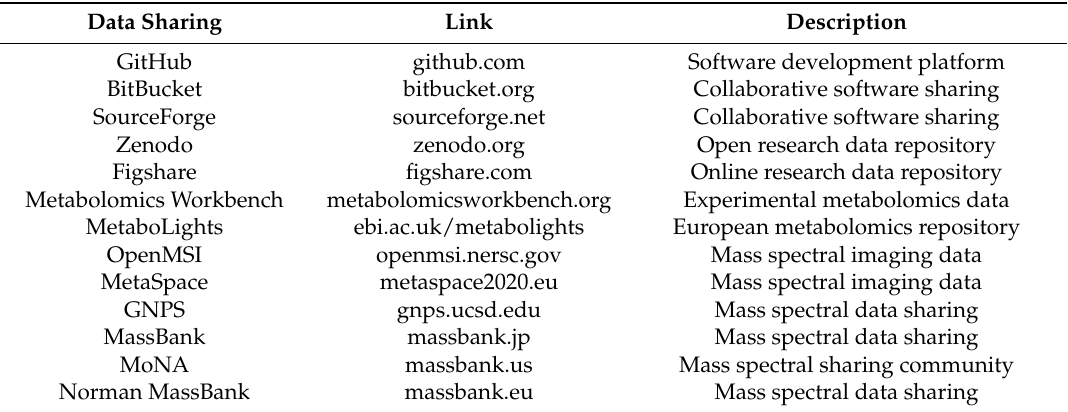
Table 6. Overview of collaborative software and data sharing repositories, major metabolomics repositories and mass spectral sharing initiatives.